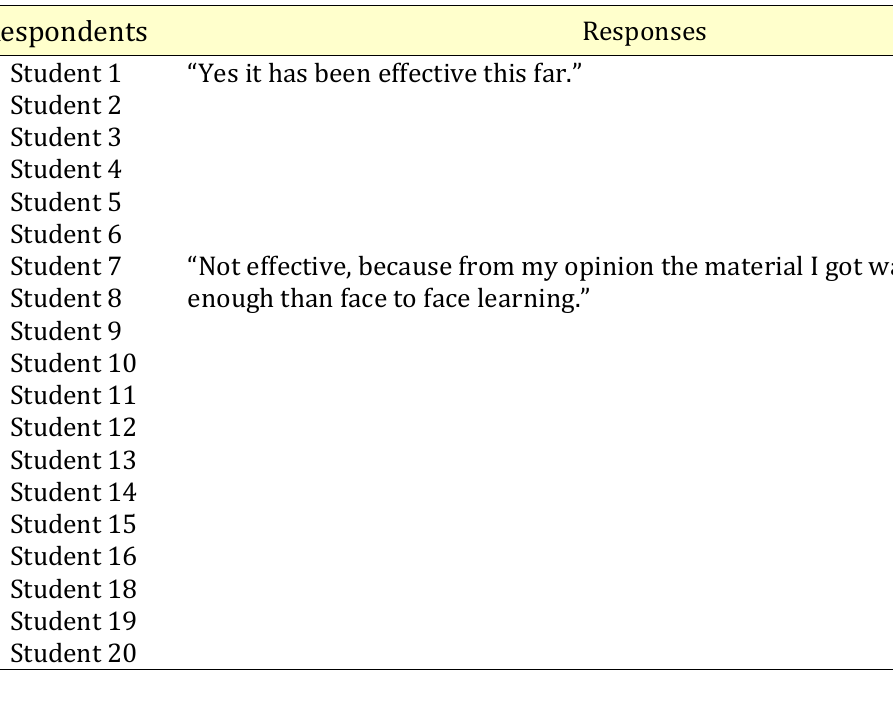
Table 2. Students from the 5th semester of English Education’s